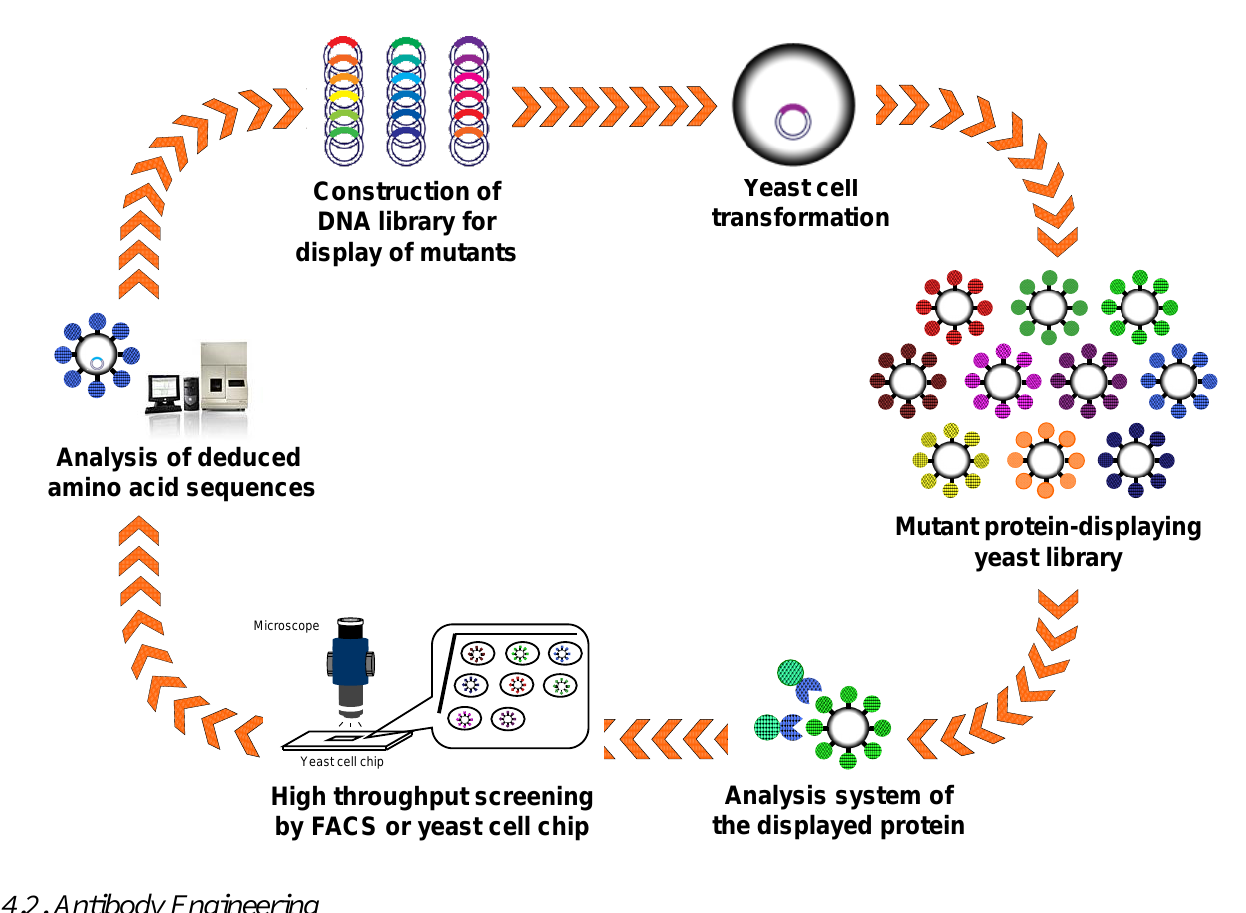
Figure 3. Creation of novel proteins/peptides with improved or developed function by arming